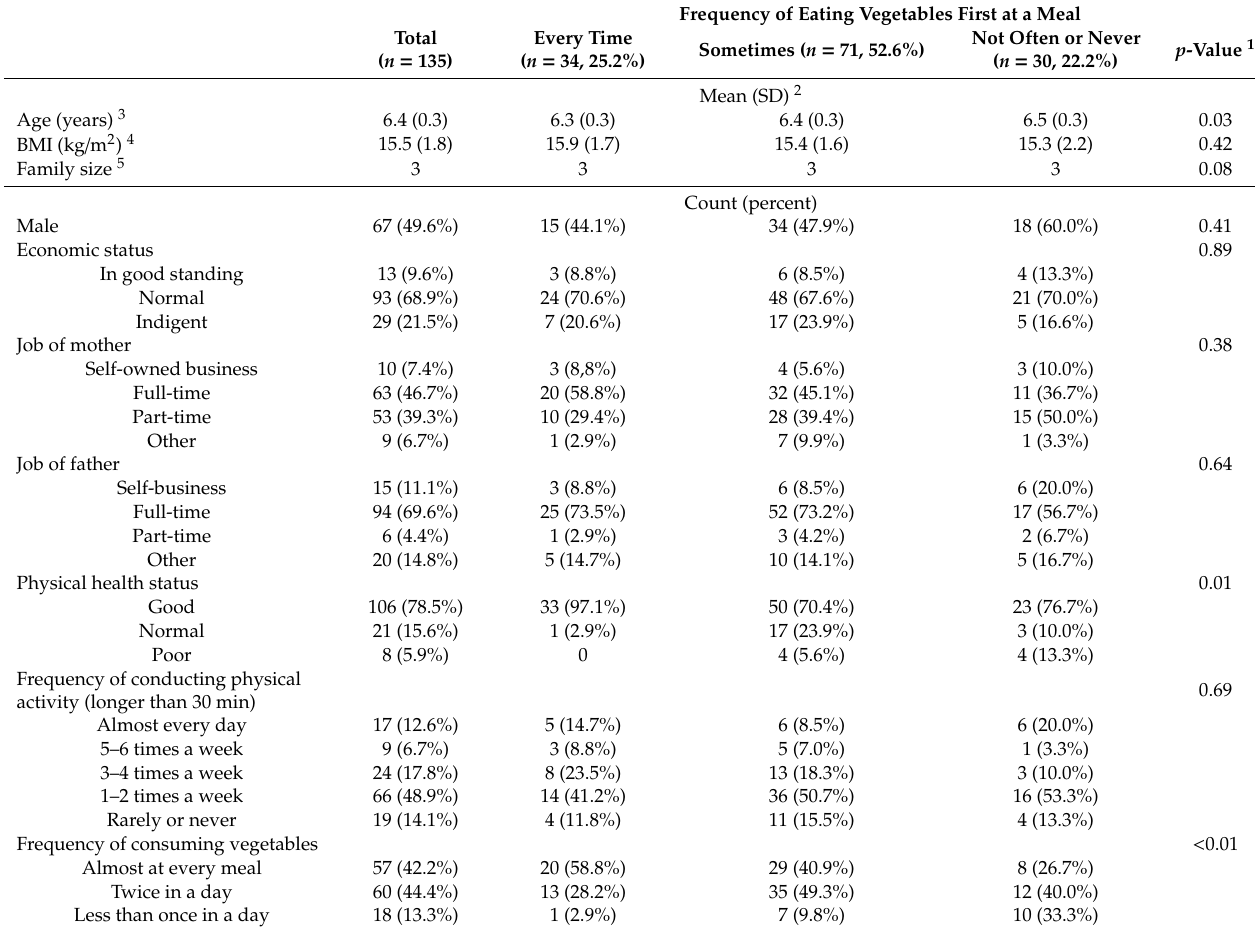
Table 1. Population characteristics and characteristics by frequency of eating vegetables first at a